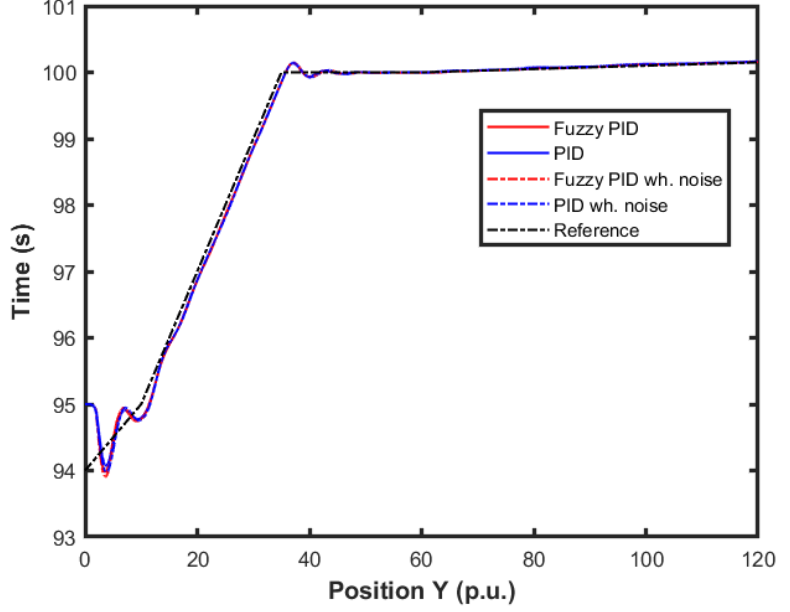
Figure 16. Comparison of the proposed method among others for position control in the